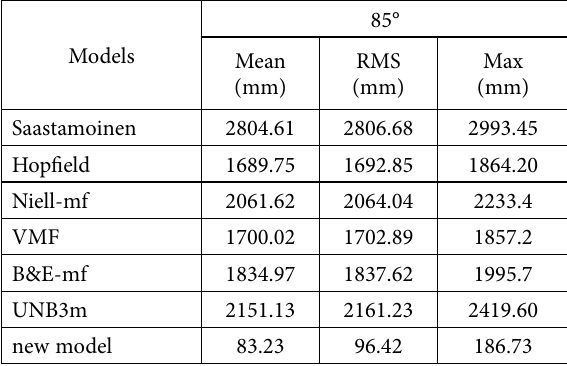
Table 7. Tropospheric delay difference (in mm) between